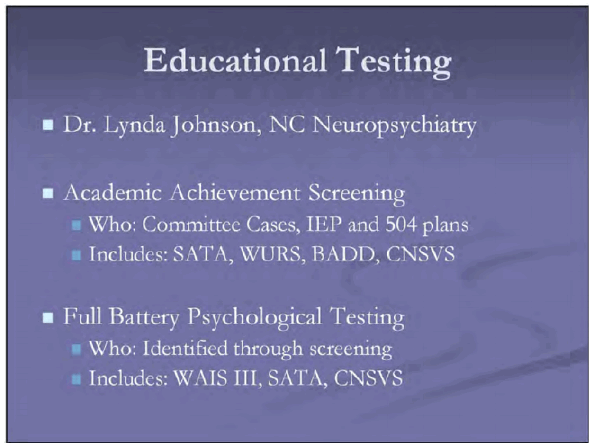
Figure 1: UNC's Description of Educational Testing for Scholarship Athletes 8